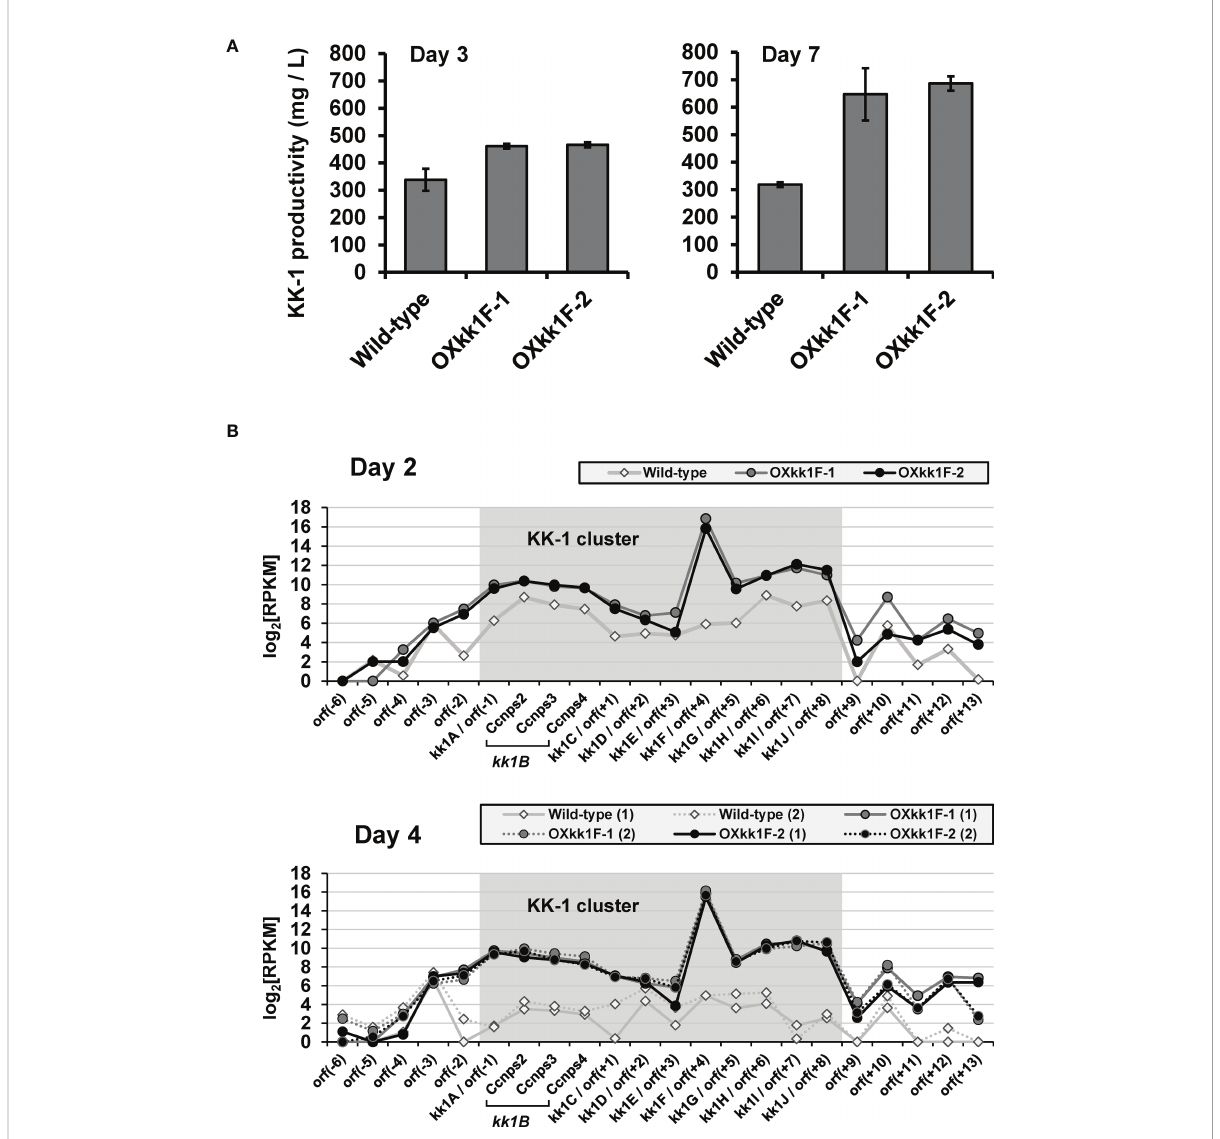
FIGURE 7 Analysis of kk1F overexpression strain. (A) The KK-1 productivity of the wild-type and two kk1F overexpression strains (OXkk1F-1, OXkk1F-2) on day 3 and day 7 of the culture. The error bars represent standard deviations (three biological replicates). (B) The reads per kilobase of exon per million mapped reads (RPKM) expression values in log2 scale for the putative KK-1 biosynthetic gene cluster corresponding to the gene IDs from kk1A to kk1J that are shown as shading and the surrounding genes in the above three strains on day 2 and day 4 of the culture. The numbers (1) and (2) indicate biological replicates. The region containing Ccnps2 , Ccnps3 , and Ccnps4 corresponds to kk1B , which encodes non-ribosomal peptide